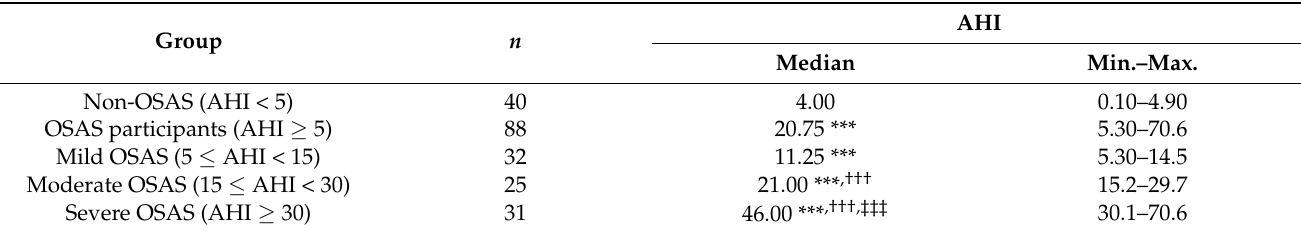
Table 2. The apnea–hypopnea index (AHI) in the participants with obstructive sleep apnea syndrome (OSAS) and in non-OSAS